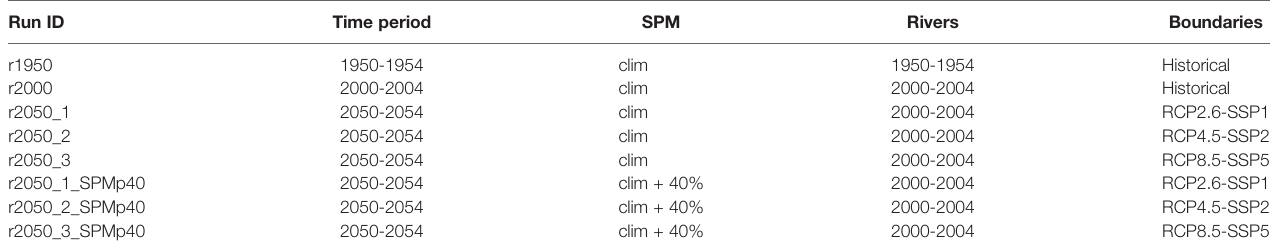
TABLE 2 | Summary of all runs. “ clim ” refers to monthly climatological means for the period of 1998 – 2017. Run ID Time period SPM